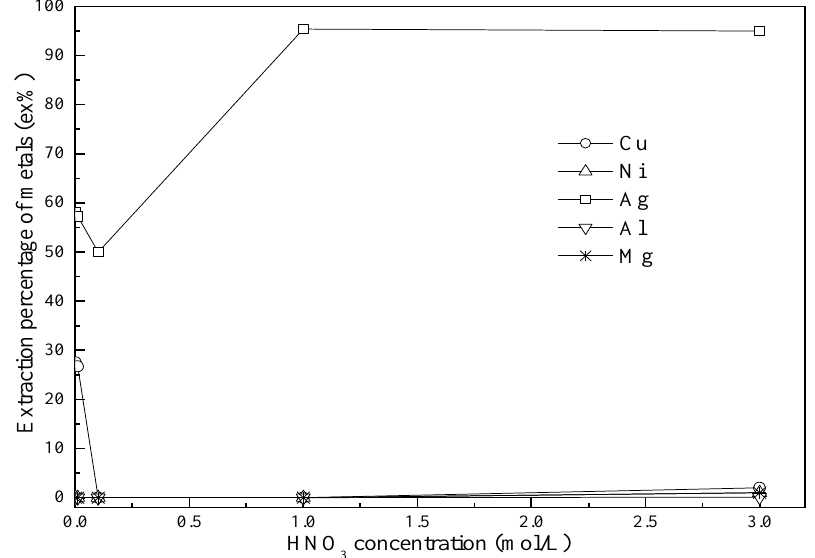
Figure 1. Effect of HNO 3 concentration on metal extraction. The extraction percentages of Ni(II), Mg(II), and Al(III) in all the extraction experi- ments were ~0%. Further experiments were performed using a 0.001 mol/L HNO 3 solu- tion.